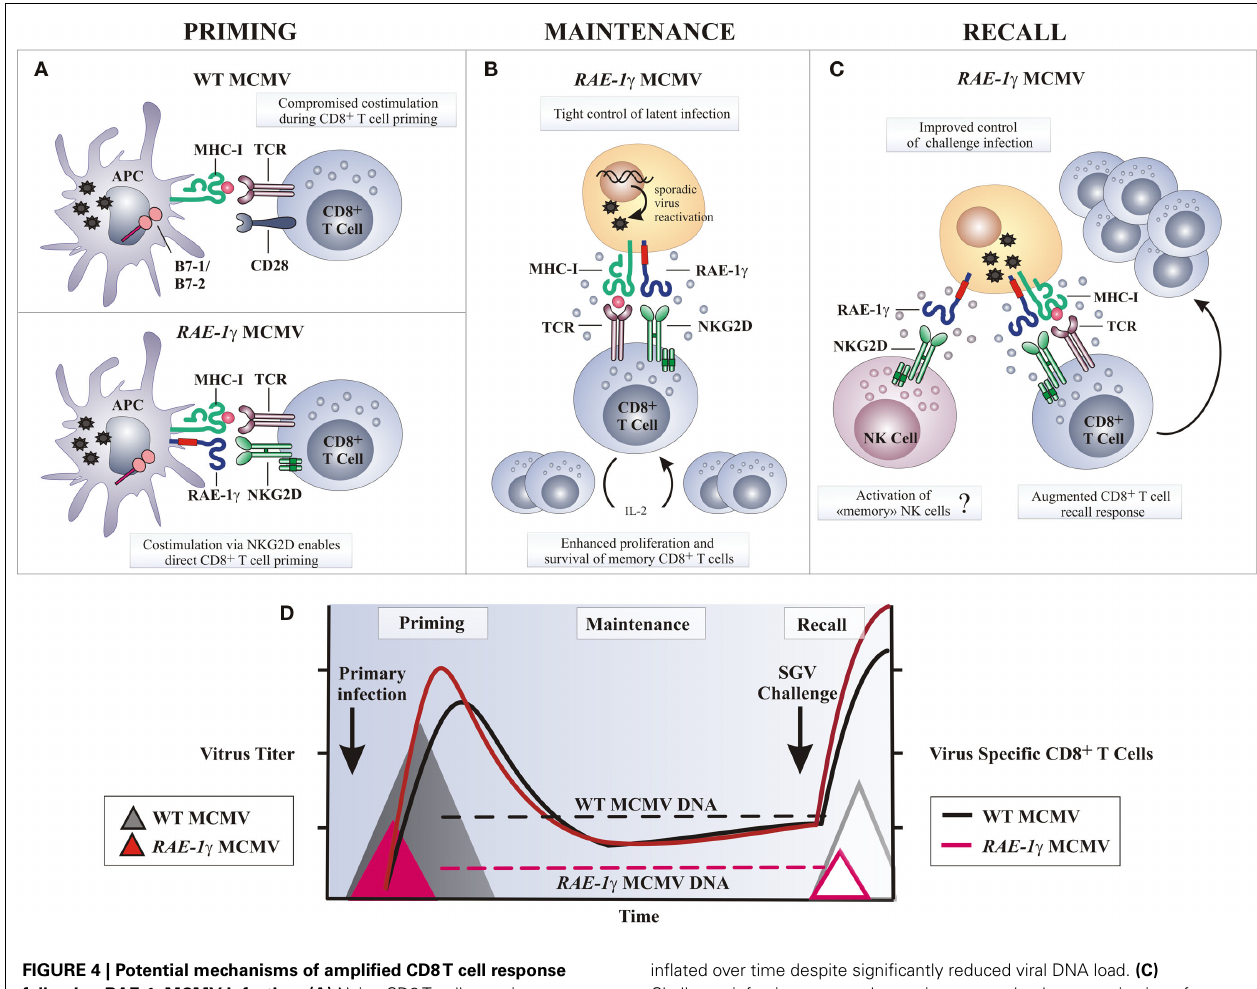
FIGURE 4 | Potential mechanisms of amplified CD8T cell response following RAE-1 γ MCMV infection. (A) Naive CD8T cells require engagement of theTCR by MHC-I molecules presenting antigen along with co-stimulatory signals, such as CD28 ligation by molecules of B7 family, to be fully activated.Wild-type MCMV (WT MCMV) dowmodulates B7.1 and B7.2 from the surface of infected APCs resulting in compromised T cell priming. Following RAE-1 γ MCMV infection co-stimulation via RAE-1 γ –NKG2D interaction may replace B7-CD28 interaction and